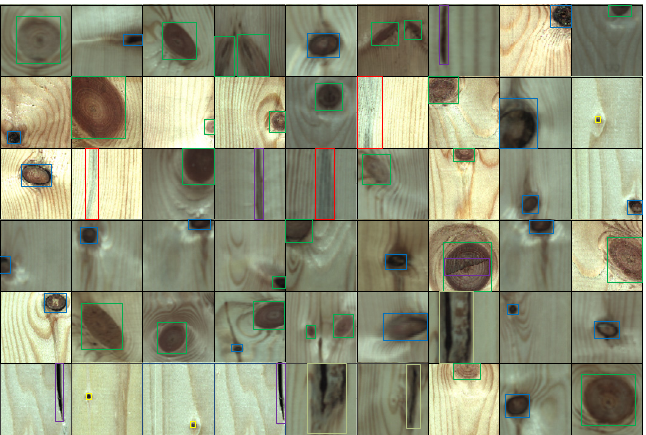
Figure 3. Image data enhancement. ( a ) Mirrored or rotated images at different angles. ( b ) Changed image contrast. ( c ) Scaled image at a scale of 0.8 and 1.2.